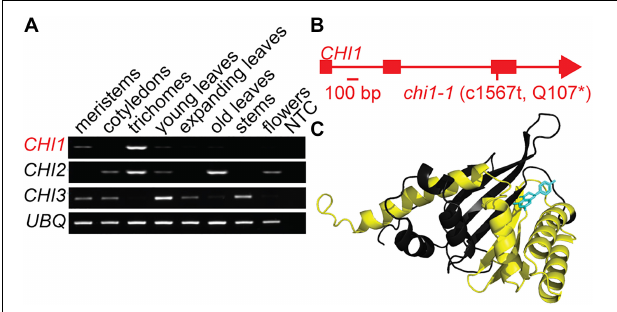
FIGURE 1 | Discovery and characterization of the chi1-1 mutation. (A) Artemisia annua CHI1 , CHI2 and CHI3 expression in meristems, cotyledons, young leaf trichomes, young leaves, fully expanded leaves, mature leaves, stems, flowers, and no template control (NTC) were determined by semi-quantitative PCR. UBQ (Putative ubiquitin-like protein, GQ901904) was used as a loading control. (B) Gene schematic of CHI1 indicates the position of the chi1-1 mutation. (C) The A. annua CHI1 protein structure was modeled by I-TASSER (Yang et al., 2015) on the 10 most closely related structural analogs. The parts of the structure expected to be missing in the chi1-1 mutant are highlighted in yellow, naringenin (enzyme product) bound to CHI1 is shown in